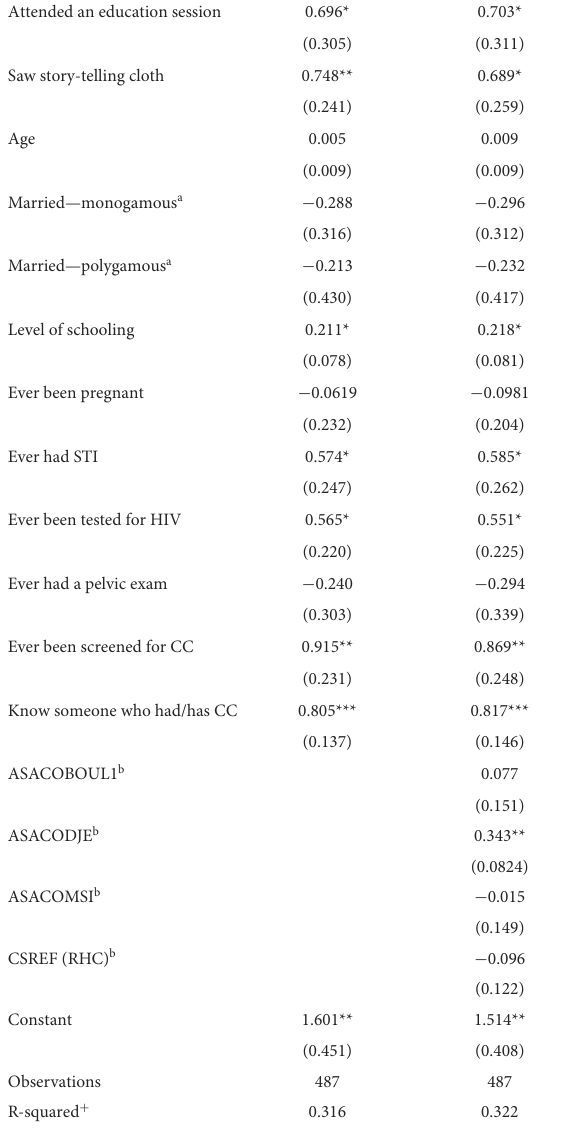
TABLE 4 Predicting knowledge about CC and HPV. Model 1 Model 2